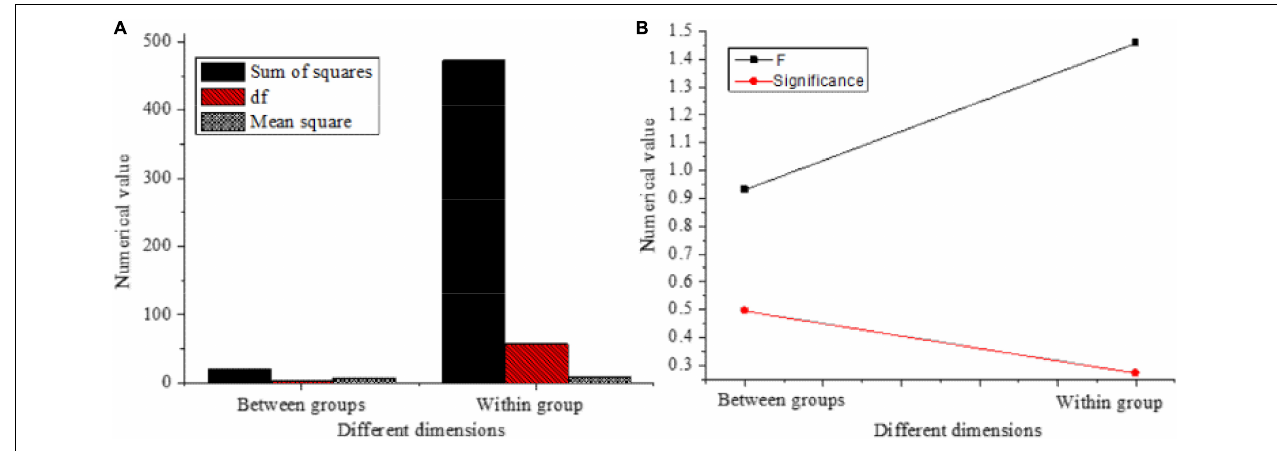
FIGURE 10 | Influence of the education level of entrepreneurs on different variables. (A) t -test results of the mean equation of different variables affected by entrepreneurs’ education. (B) Levene test results of the variance equation of different variables affected by entrepreneurs’